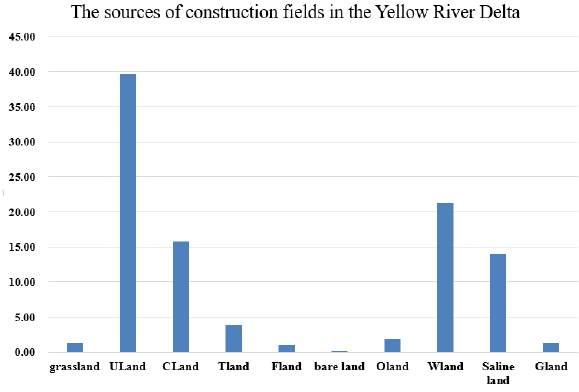
Figure 9. The sources of construction fields in the Yellow River